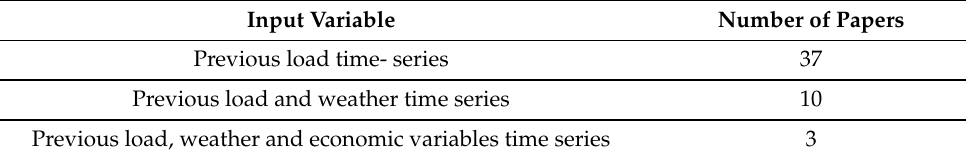
Table 3. Type of used input variables.